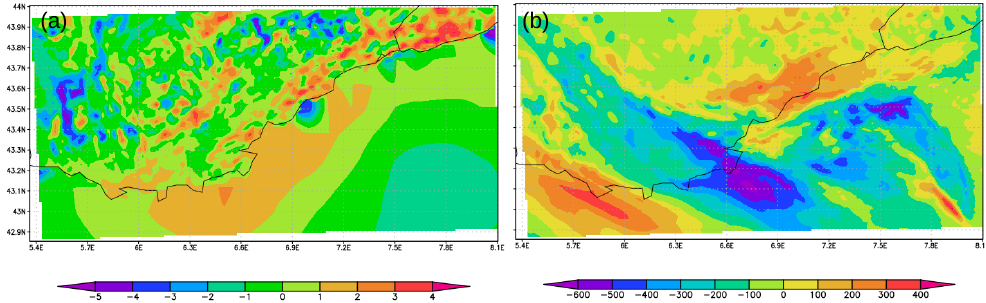
Figure 9. Panel ( a ): Surface temperature difference ( ◦ C ) between ECMWF-driven (W_ECM) simulation and GFS-driven (W_GFS) simulations, at 15 UTC, 3 October 2015. Panel ( b ): surface Convective Available Potential Energy (CAPE) difference (J kg − 1 ) between W_ECM simulation and W_GFS simulations, at 15 UTC, 3 October 2015.